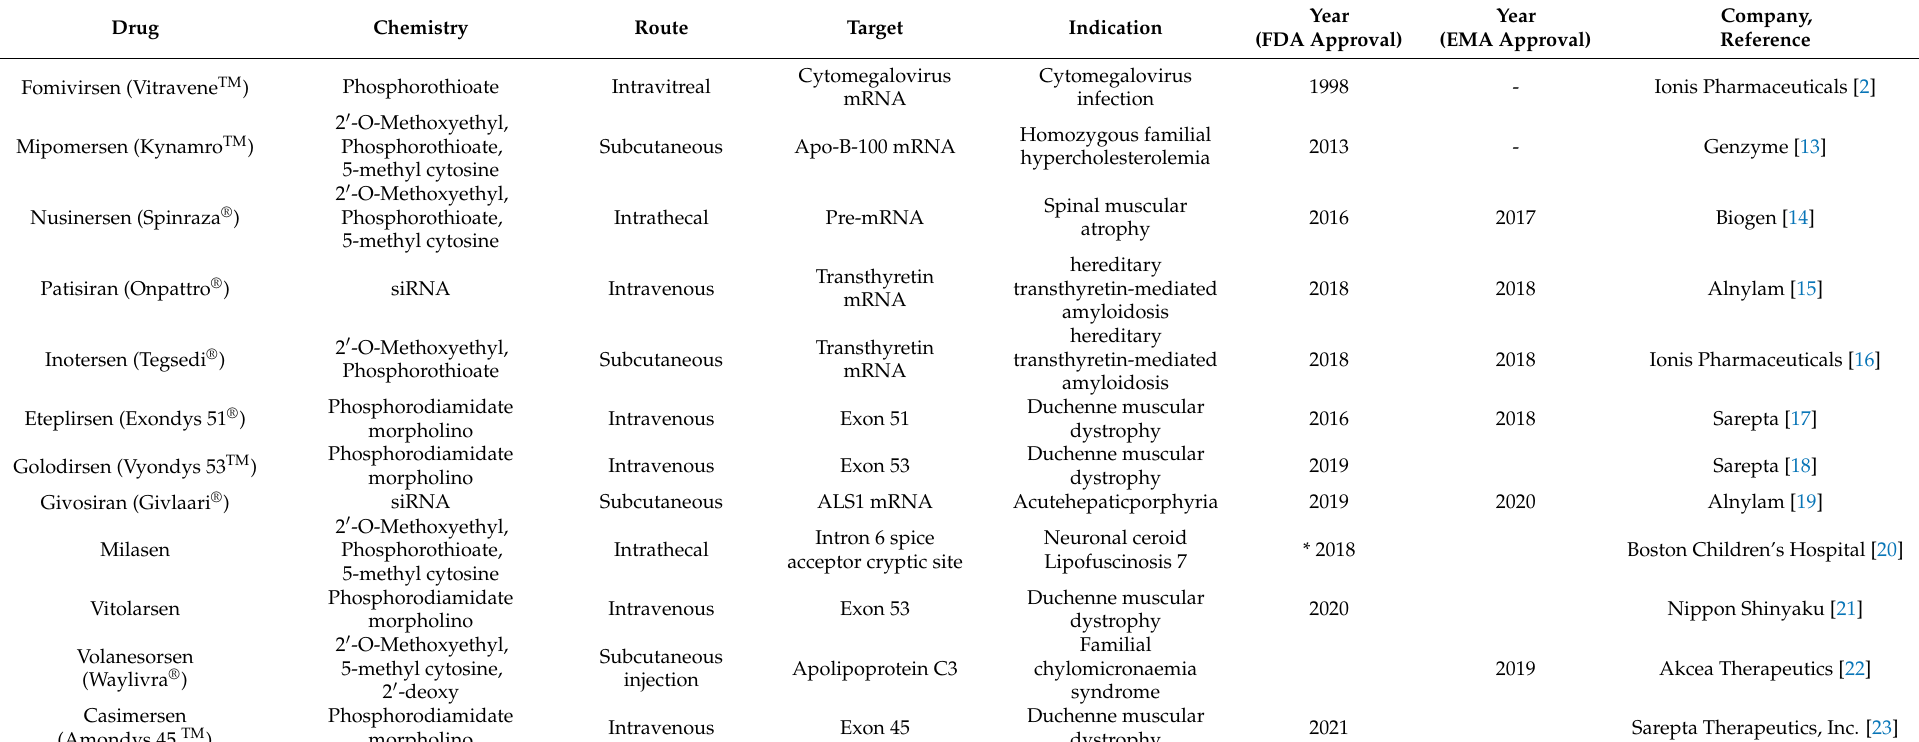
Table 1. Antisense medicines approved by the Food and Drug Administration (FDA) or European Medicines Agency